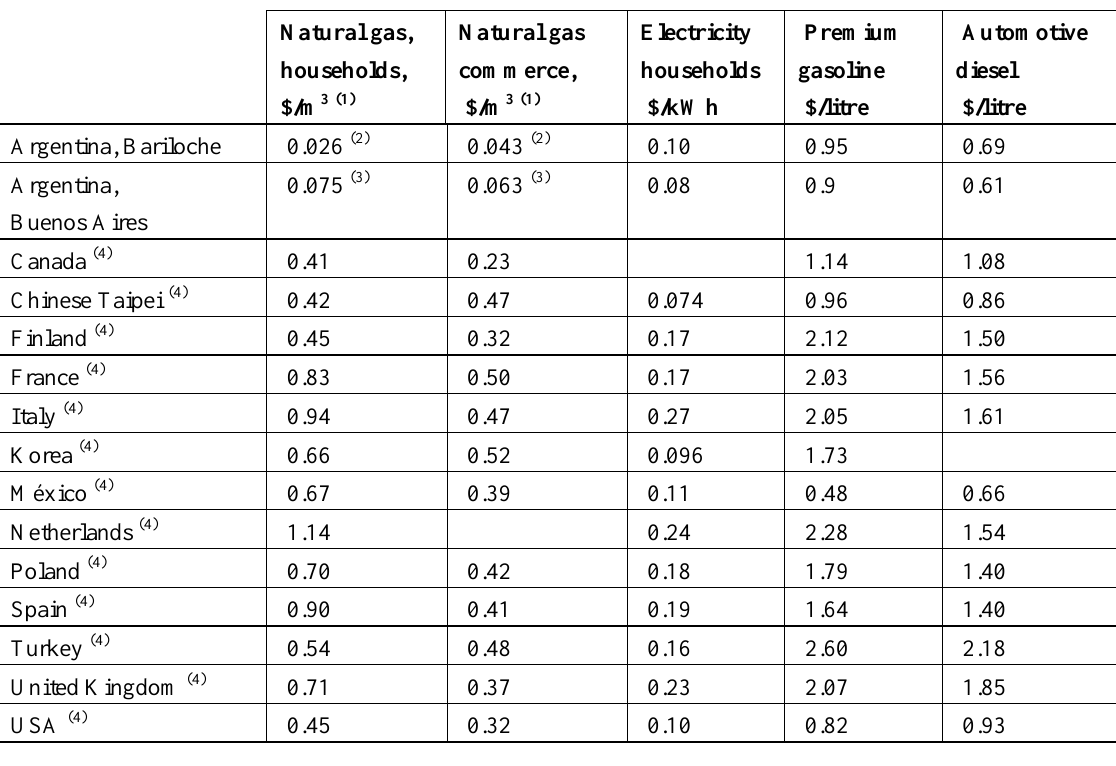
Table 1. Prices of households’ energy and vehicle fuels, in Argentina and other